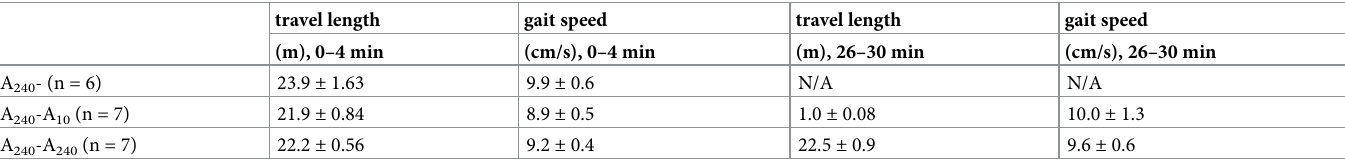
Table 1. Behavioral data of animals in three